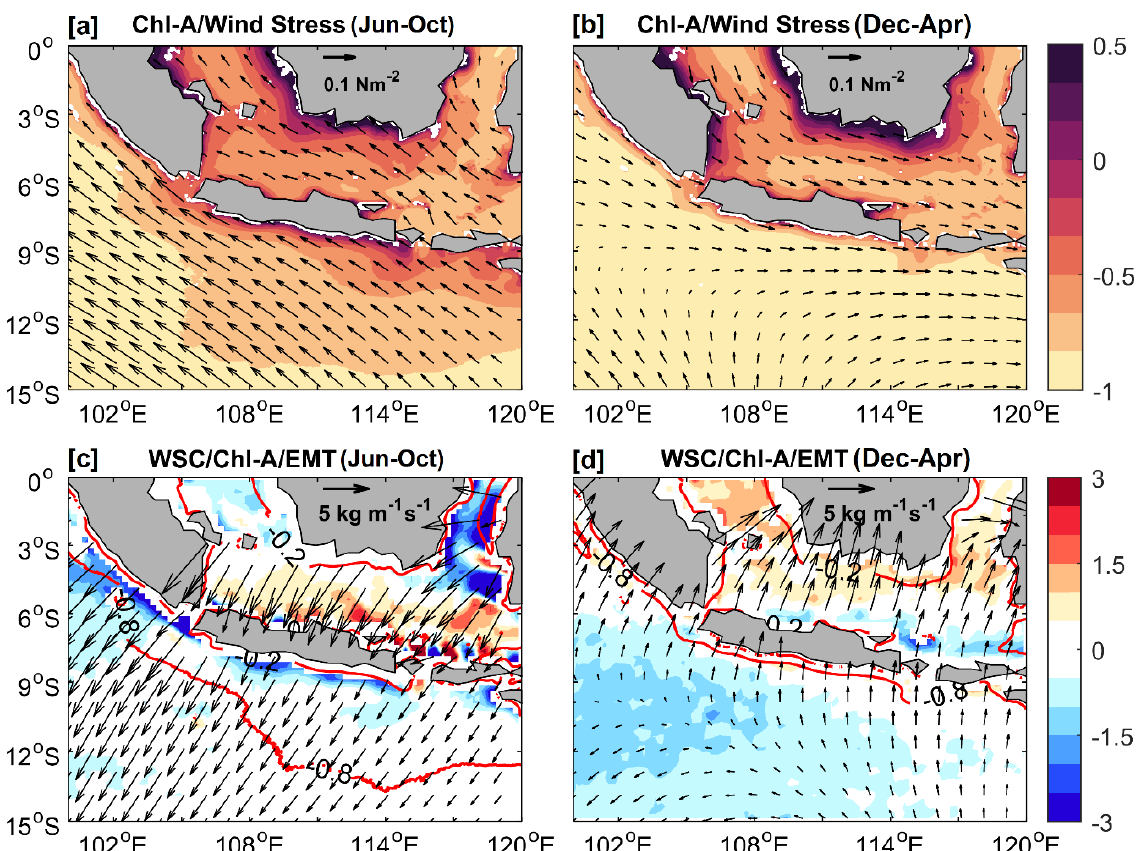
Figure 3. The seasonal variability of chlorophyll-a concentration (in mg m −3 at logarithm scale) during ( a ) June − October and ( b ) December − April, overlaid with wind stress vectors (in N m −2 ) during 2008 − 2019. ( c and d ) Similarly, for wind stress curl (in ×10 −7 N m −3 ) overlaid by vectors of Ekman Mass Transport (in kg m −1 s −1 ) and red contours of chlorophyll-a concentration ( − 0.8 mg m −3 in logarithm scale) during the same two seasons.